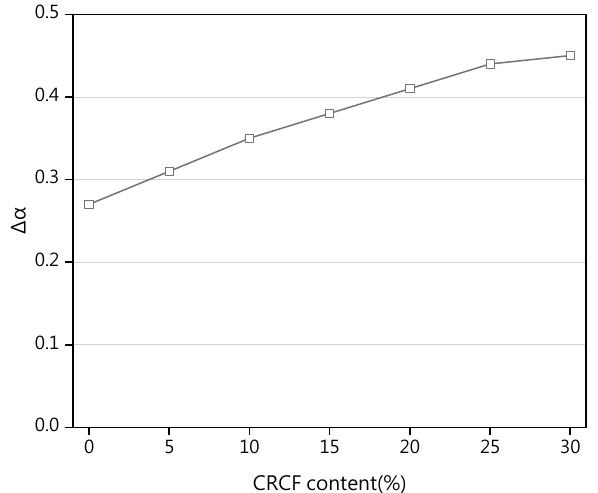
Figure 13. Relationship between Δα and CRCF content.